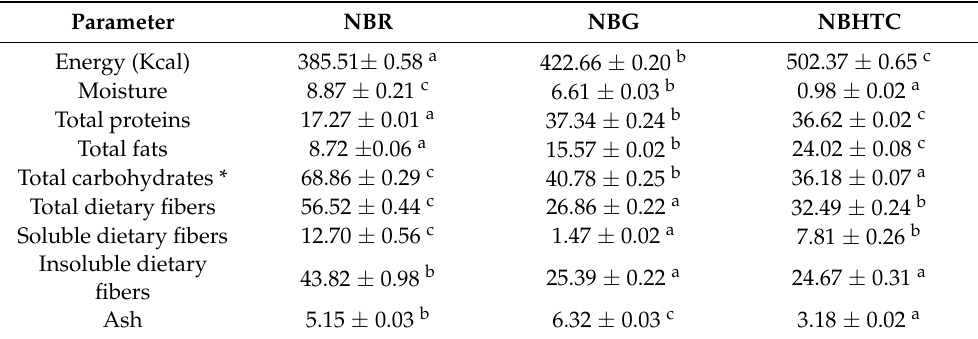
Table 2. The proximate composition of raw, germinated and hydrothermally cooked Nitta bean flours (g 100 g − 1 ) on dry weight